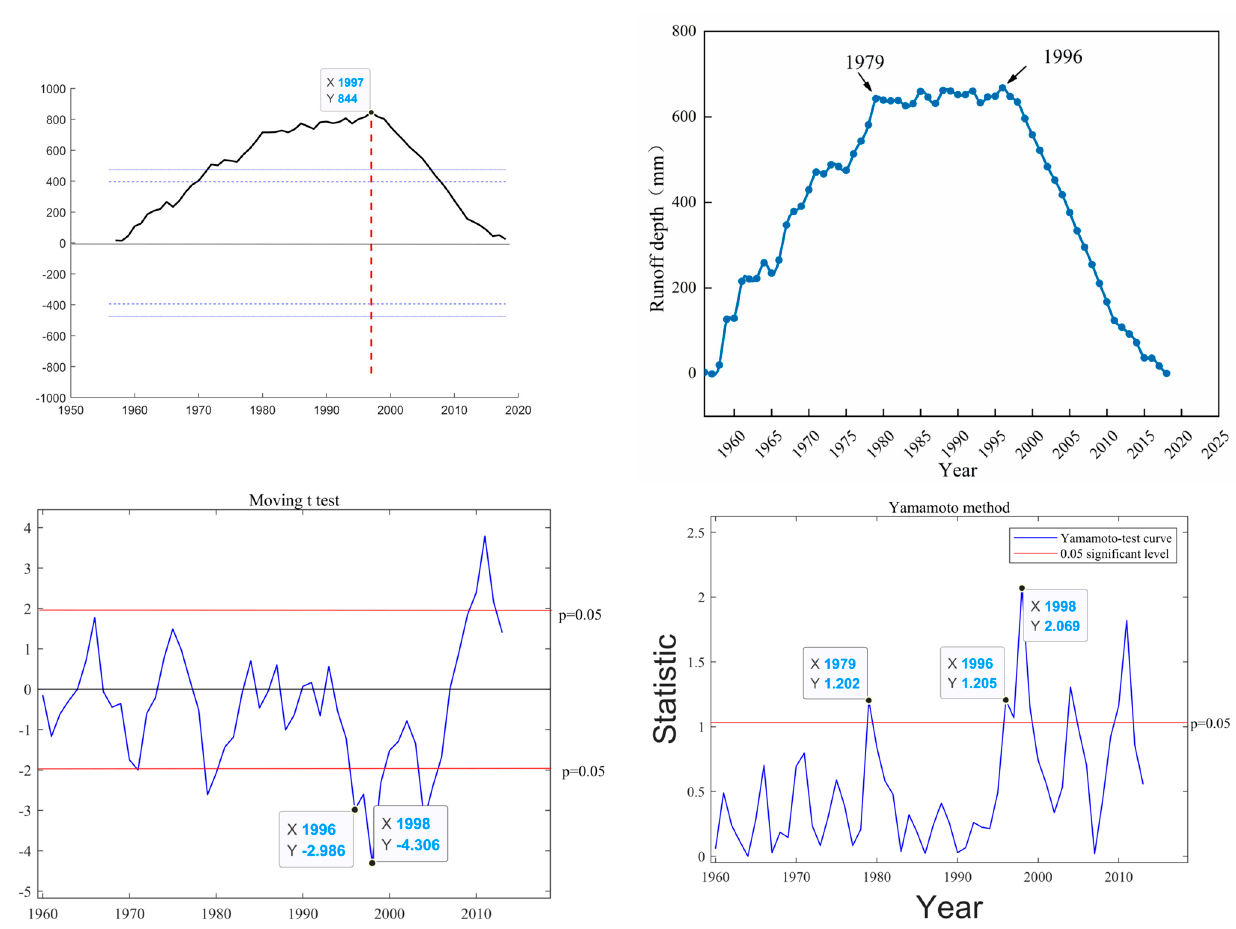
Figure 4. Pettitt test method, cumulative distance level method, moving t -test method and Yamamoto